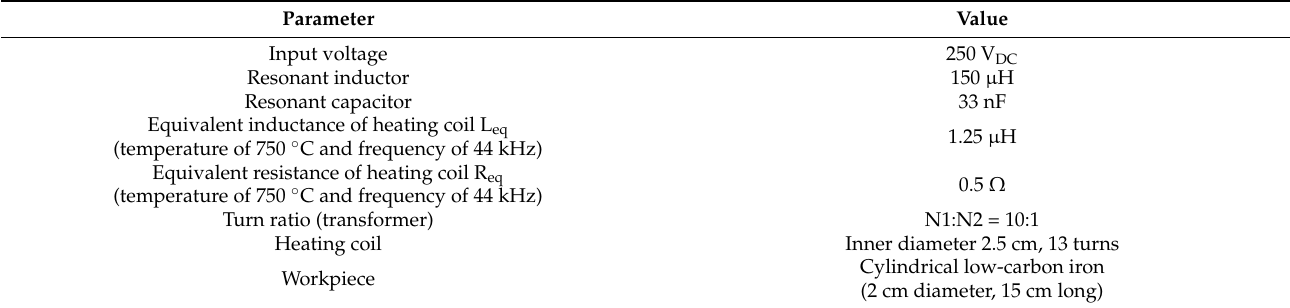
Table 4. Specification of the induction heating system.